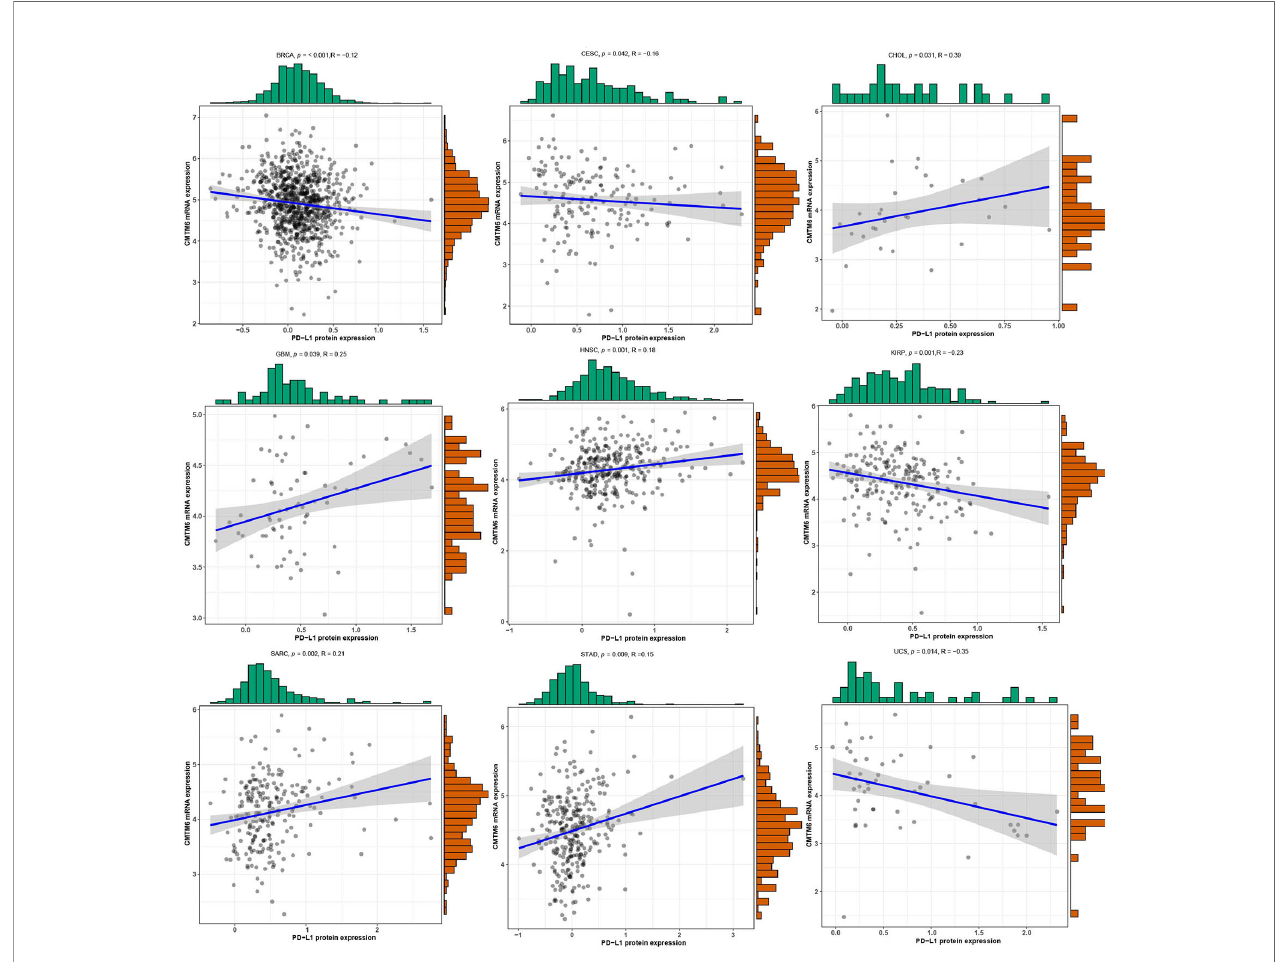
FIGURE 3 | The correlation of CMTM6 expression with PD-L1 protein expression. High CMTM6 expression was positively associated with PD-L1 protein expression in cholangiocarcinoma (CHOL), head and neck squamous cell carcinoma (HNSC), sarcoma (SARC), stomach adenocarcinoma (STAD), whereas, negative correlation was observed in breast invasive carcinoma (BRCA), cervical squamous cell carcinoma and endocervical adenocarcinoma (CESC), kidney renal papillary cell carcinoma (KIRP), and uterine carcinosarcoma